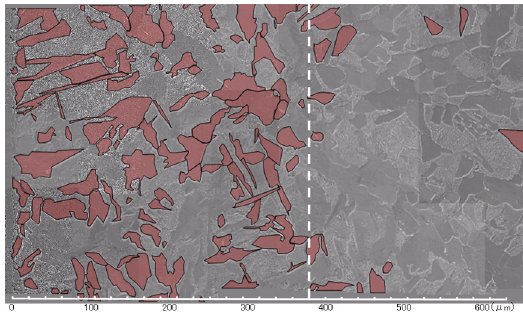
Figure 4. Cross sectional SEM observation of the nitrided specimen.